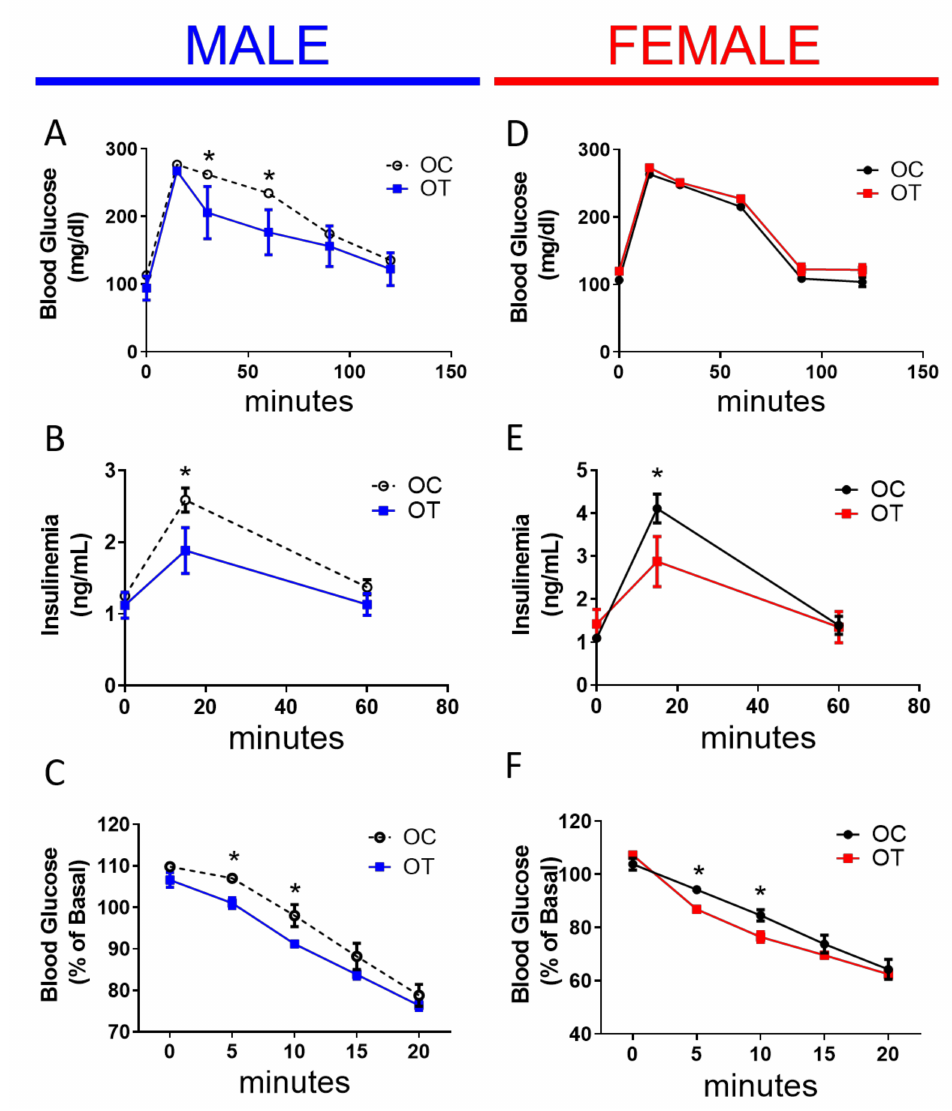
Figure 3. Offspring sired by trained male mice show improved metabolic health. ( A ) Intraperitoneal glucose tolerance tests (1 g/Kg, b.w.) ( B ), insulinemia during the ipGTT ( C ) insulin tolerance tests (1 U/Kg/b.w.) of male offspring sired by OC male (dashed black lines) or OT male mice (blue line). ( D ) Intraperitoneal glucose tolerance tests (1 g/Kg, b.w.) ( E ), and insulinemia during the ipGTT ( F ) insulin tolerance tests (1 U/Kg/b.w.) of female offspring sired by OC male (solid black line) or OT male mice (red lines). Data are presented as the mean ± SEM. * p ≤ 0.05 vs. OT using two-tailed t test. n =